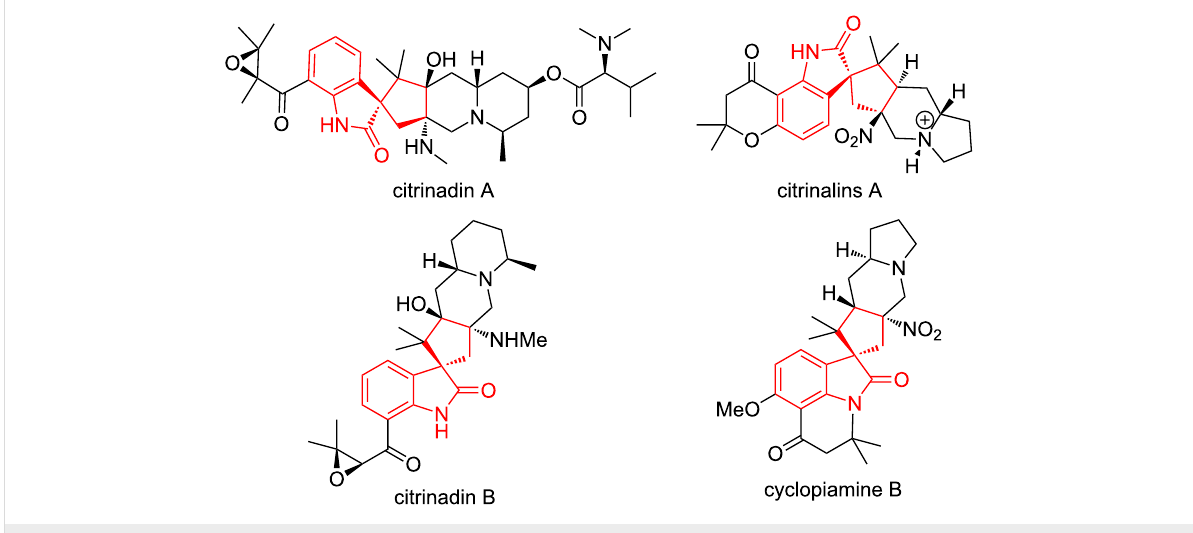
Figure 1: Representative spirooxindole natural